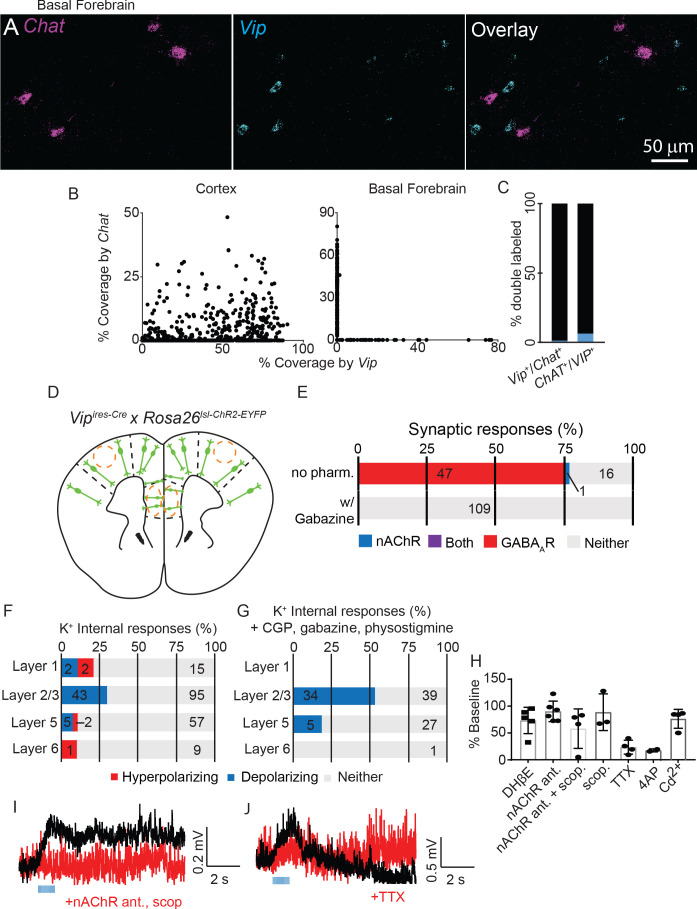
Synaptic connectivity from VIP+ neurons, which excludes basal forebrain cholinergic neurons, results in little to no detectable muscarinic ACh receptor-mediated responses.(A) Example fluorescent in situ hybridization for Chat and Vip. While Vip-expressing neurons are present in the basal forebrain, they do not colabel with Chat. (B) Comparison of cell coverage by Vip and Chat signal between the cortex and basal forebrain. In the cortex, all neurons with positive cell coverage by Chat also label with Vip. In the basal forebrain, cell coverage by Vip and Chat are mutually exclusive. (C) Summary quantification of the proportion of double-labeled Chat- and Vip-expressing neurons (n = 1 Vip+/Chat+, 41 Vip+ only, 183 Chat+ only cells from 3 wild-type mice). (D) Experimental design: Acute slices from Vipires-Cre x Rosa26lsl-ChR2-EYFP mice were prepared and whole cell recordings with obtained from neurons in different cortical layers. (E) Summary quantification of the proportion of layer 1 interneurons showing synaptic responses following whole-cell voltage clamp and optogenetic stimulation. The responses from both M1 and mPFC, were not significantly different (see Figure 6I–L), and are pooled here. For a significant portion of our recordings, we included we included gabazine in the bath to improve screening for nAChR-mediated currents (n = 174 neurons from 14 Vipires-Cre x Rosa26lsl-ChR2-EYFP mice). (F) Summary quantification of the proportion of cells in whole-cell current clamp showing a synaptic response following trains of optogenetic stimulation of VIP+ interneurons (3 ms pulse, 20 × 20 Hz). Numbers indicate the number of neurons in each category. (n = 231 neurons from 21 Vipires-Cre x Rosa26lsl-ChR2-EYFP mice G) Summary quantification of a subset of cells recorded in (F) were obtained in the presence of gabazine, GABABR-antagonist CGP-35348, and ACh esterase-inhibitor physostigmine in order to improve the chances of observed nAChR- or mAChR-mediated voltage responses. (n = 106 neurons from 10 Vipires-Cre x Rosa26lsl-ChR2-EYFP mice). (H) Summary quantification of the sensitivity of depolarizing responses to different antagonists, including DHβE to block only non-α7 containing nAChRs, a nAChR antagonists cocktail to block all nAChRs (containing MEC, MLA, and DHβE), and scopolamine to block muscarinic ACh receptors. These depolarizing responses were largely insensitive to different ACh receptor antagonists, with one exception shown in (H). We also blocked these responses with voltage-gated sodium channel antagonist TTX, but could not rescue with subsequent addition of 4AP. Finally, these depolarizing responses were insensitive to Cd2+, which inhibits release of synaptic vesicles. Based on these results, we conclude that these depolarizing responses are an artifact of strong synchronous stimulation of VIP+ interneurons resulting in ephaptic potentials. (I) Example depolarizing response that was blocked by ACh receptor antagonists. (J) Additional depolarizing example response that is partially sensitive to block by TTX.